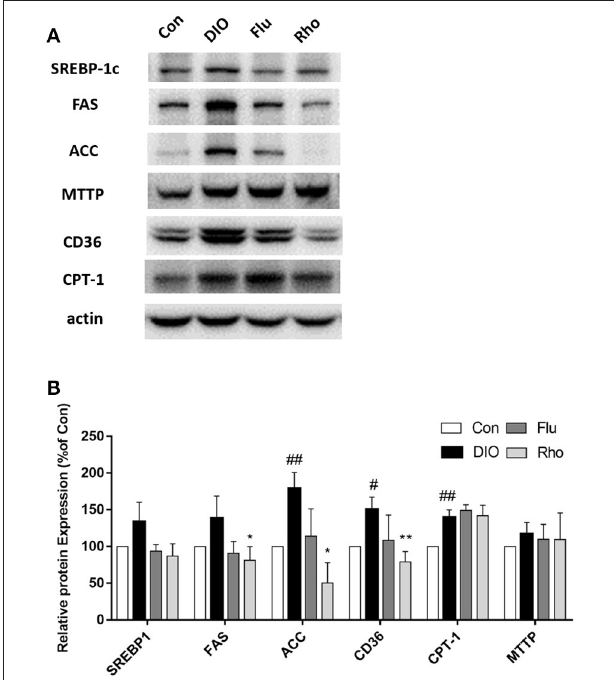
FIGURE 5 | Effect of Rho on the pathways involved in hepatic lipid metabolism in DIO mice. (A) Expression of CD36, SREBP-1, FAS, ACC, CPT-1, and MTTP in liver. (B) Band intensities of proteins quantified by densitometry. Each data is from three independent tests. # p < 0.05, ## p < 0.01 vs. Con; * p < 0.05, ** p < 0.01 vs.